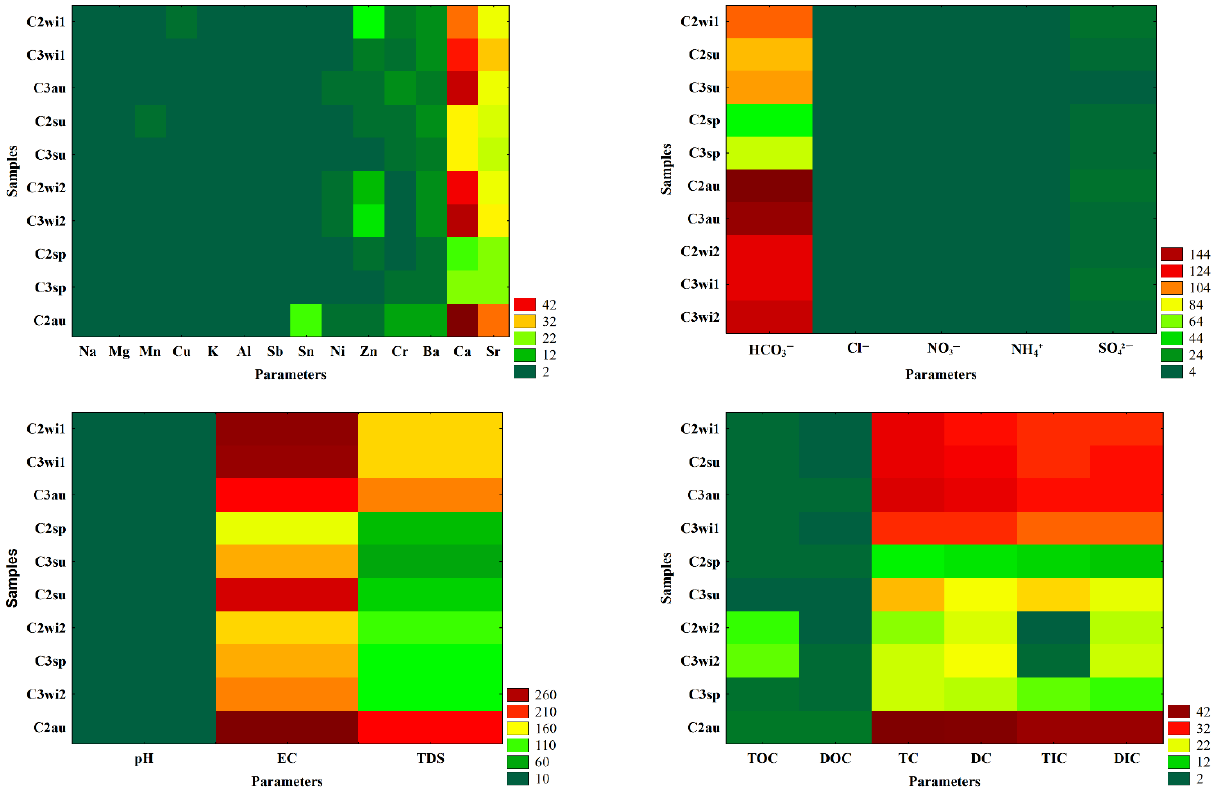
Figure 4. Heat maps after the two-way joining analysis as a clustering method to emphasize the seasonal variations, similarities or lack thereof between the water samples collected from Clo ș ani Cave. C2—water samples collected from a small pool on the clayish floor, C3—water samples collected from a small pond on calcite. wi—winter; sp—spring; su—summer; au—autumn. The measurement units of the parameters are presented in Tables 1 and 2.